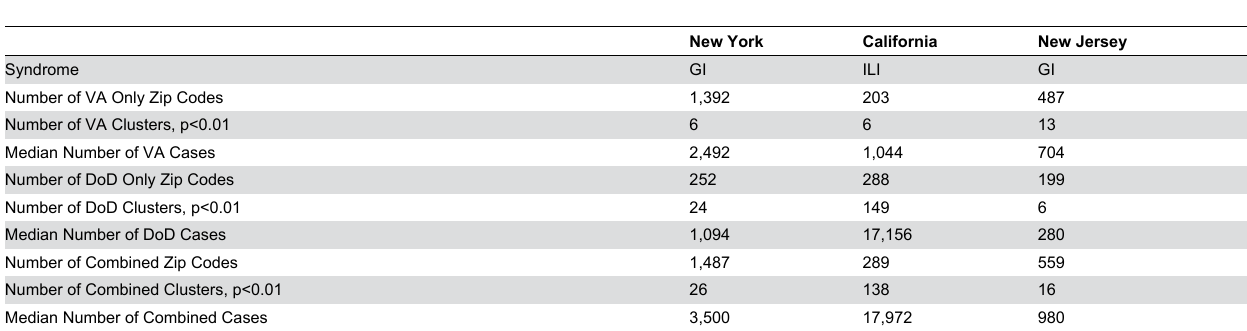
Table 5. Results of sets of cluster determination daily runs conducted from August 9, 2009 to June 10, 2010 using data from regions of reported outbreak